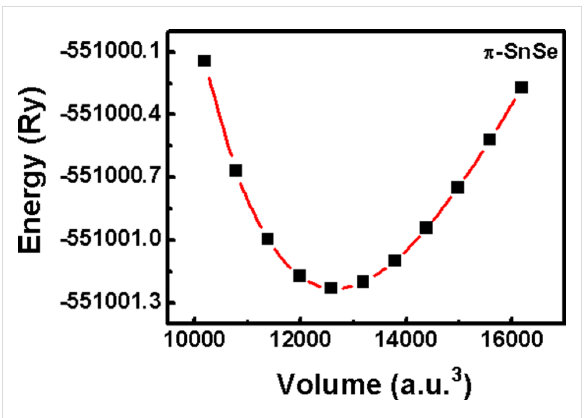
where E ( V ) and E o are the total energies at the deformed ( V ) and reference ( V o ) volumes, respectively, and B o and repre- sent the bulk modulus and its first-order pressure derivative, re- spectively [9,56,57]. The volume–energy optimization curve of the π -SnSe is shown in Figure 2.